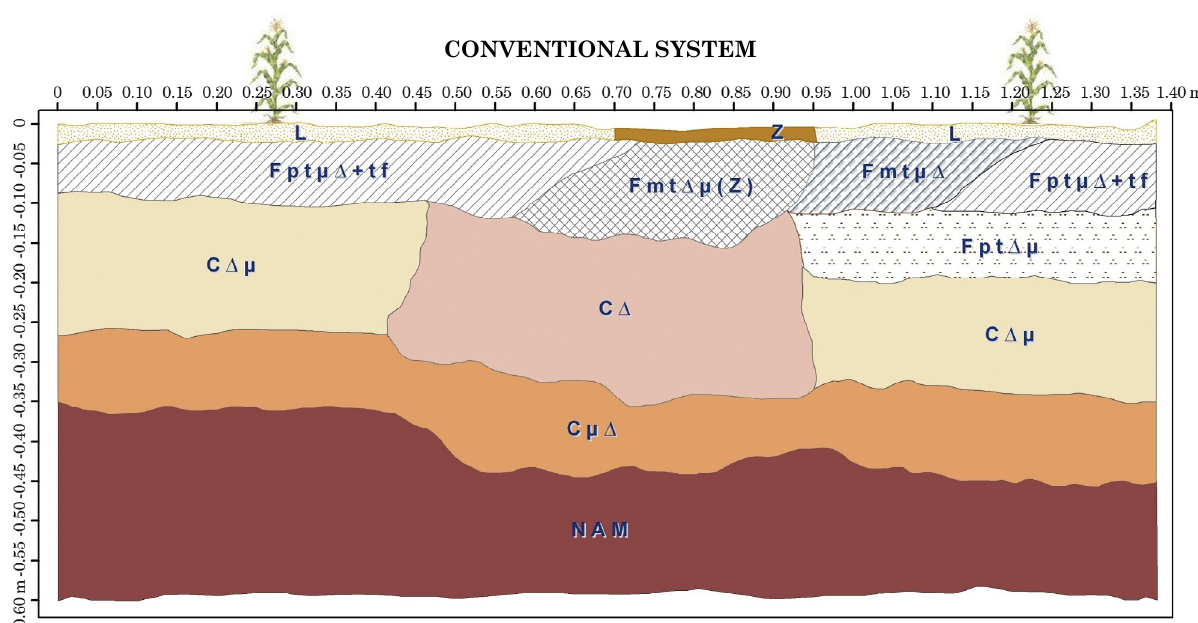
Figure 2. Schematic representation of the different organizations of the crop profile under the Conventional System. L: volume of loose soil, not compact, “powdered”; F or C: fragmented or continuous volumes of soil; ∆μ or μ∆: compact or porous clods, with very compact aggregates (∆), compact (∆μ) and in compaction process (μ∆); pt, mt, gt: small, medium or large clods; tf: fine soil; and NAM: not altered by management.